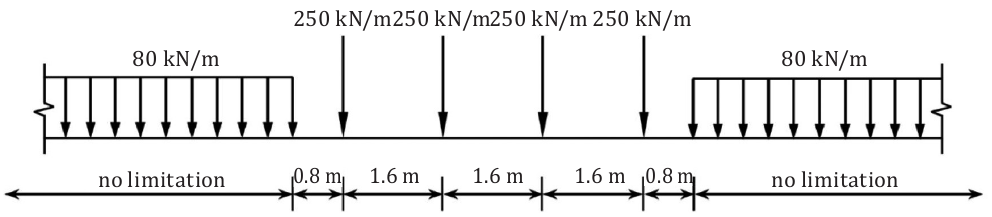
0.8 m 0.8 m1.6 m1.6 Figure 8. Live load model UIC-71 (UIC 776-1, 2006)